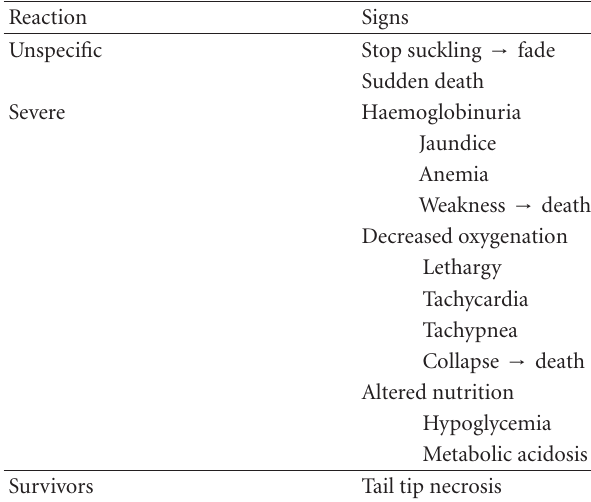
Table 4: Key signs to FNI diagnosis.